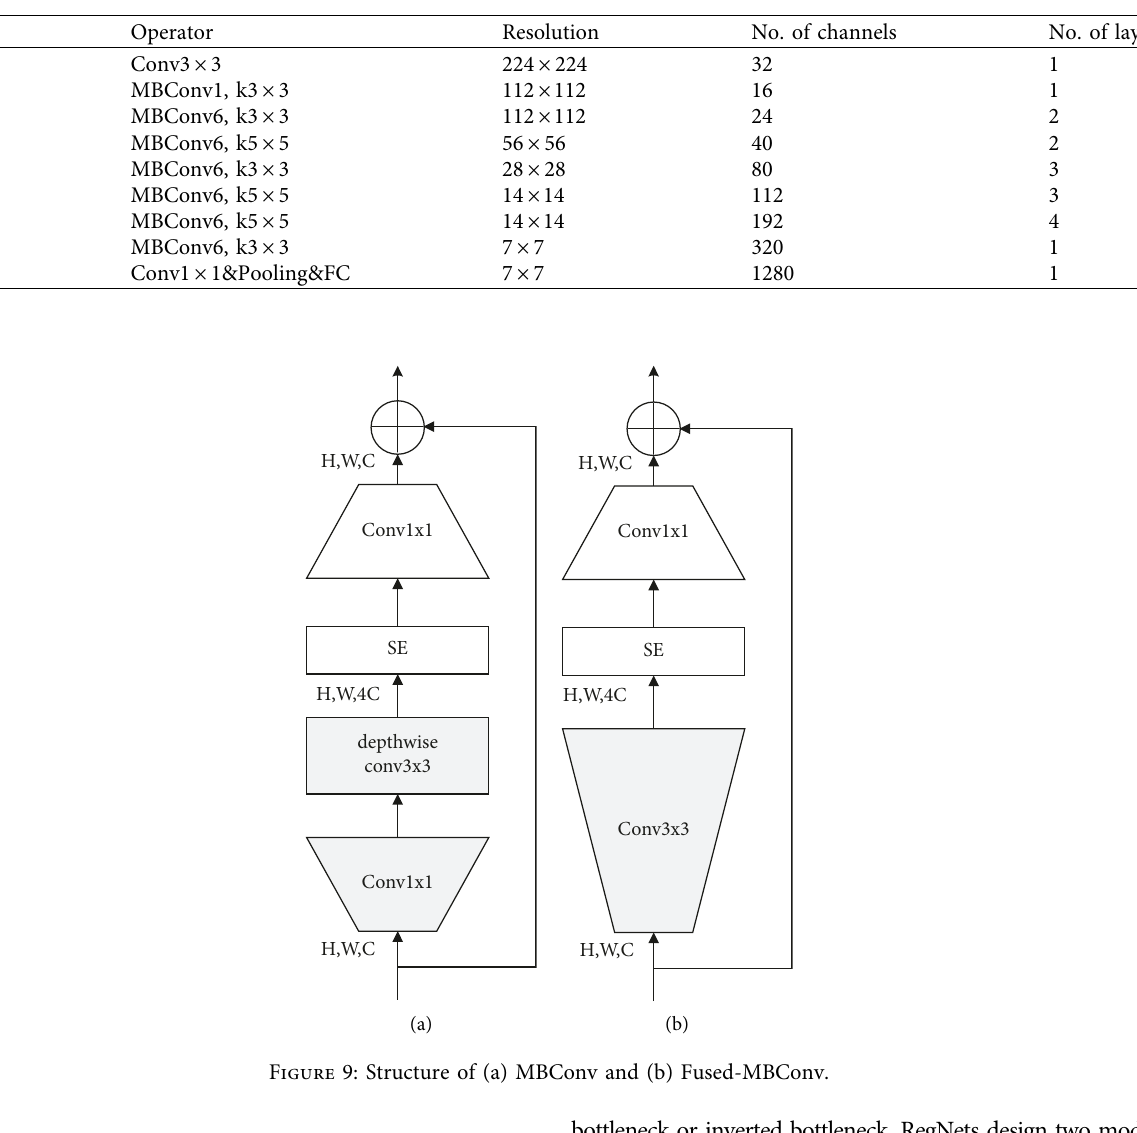
Table 5: Architectures of EfficientNet-B0 baseline.